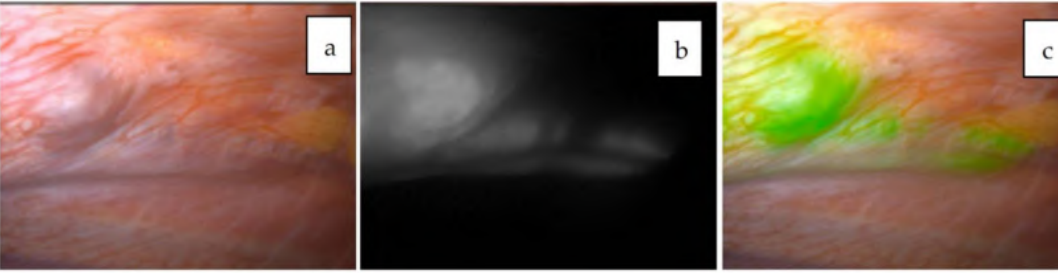
Figure 7. Pleural metastasis visualized with the Pinpoint system. Normal white-light mode ( a ), NIR mode ( b ), and overlay mode ( c ) are shown. The tumor is visualized as a green color overlaid on the white-light mode